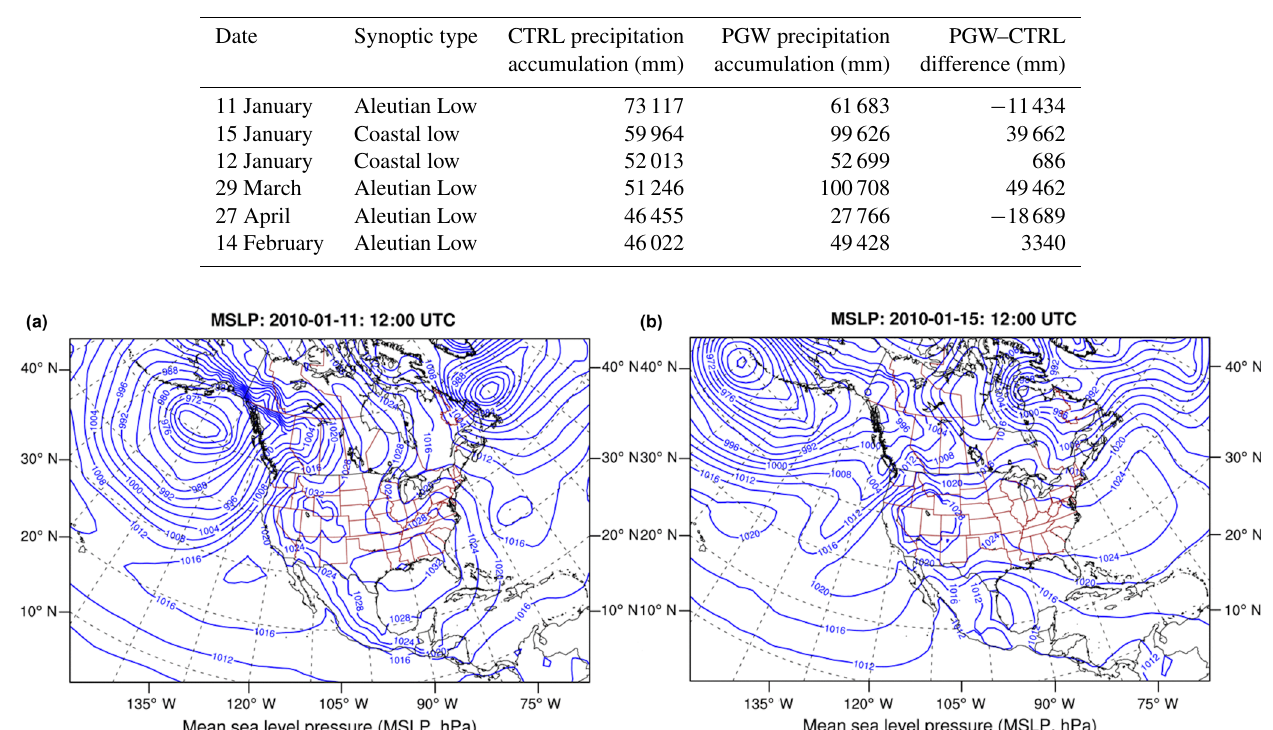
Table 4. Events within the top fifth percentile over the January–April 2010 period in terms of total transition region precipitation accumulation in the CTRL and PGW simulations.